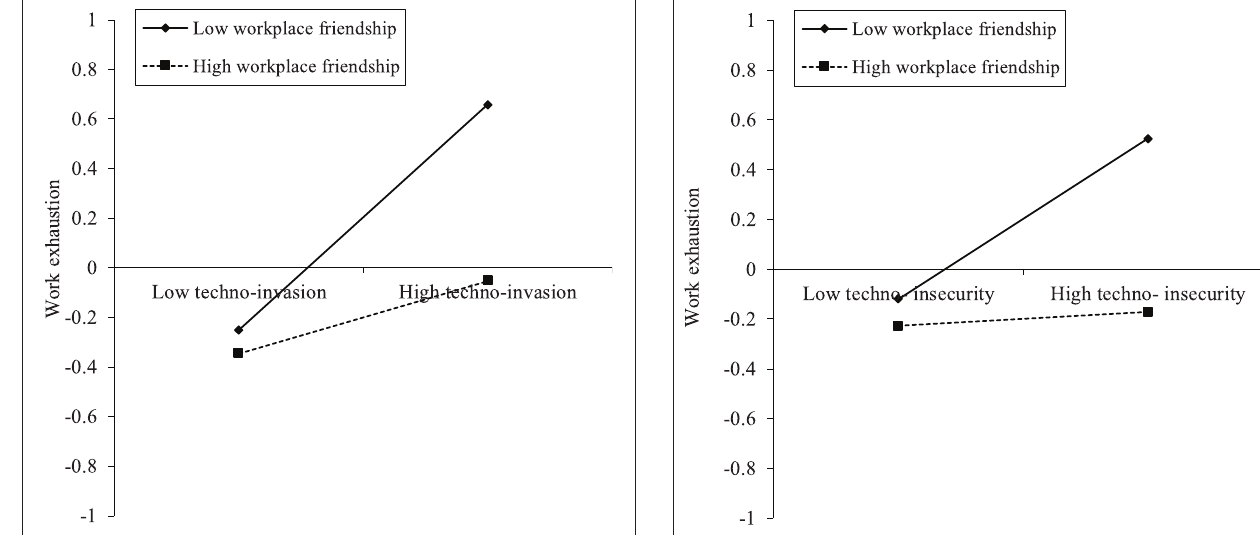
FIGURE 5 | The interaction of techno-insecurity and WF on work exhaustion ( N =